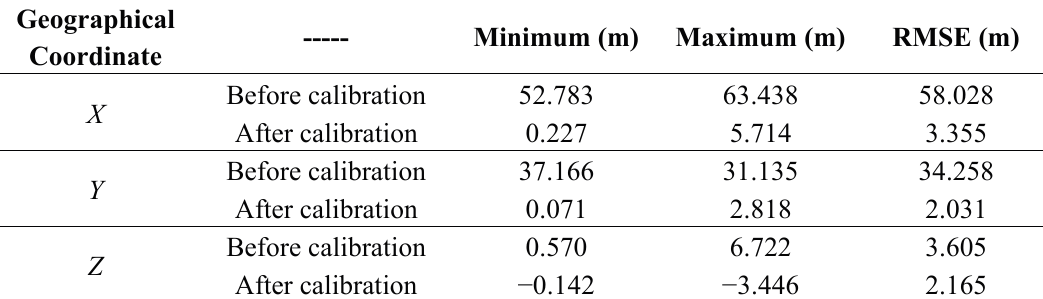
Table 3. Position accuracy comparison before and after